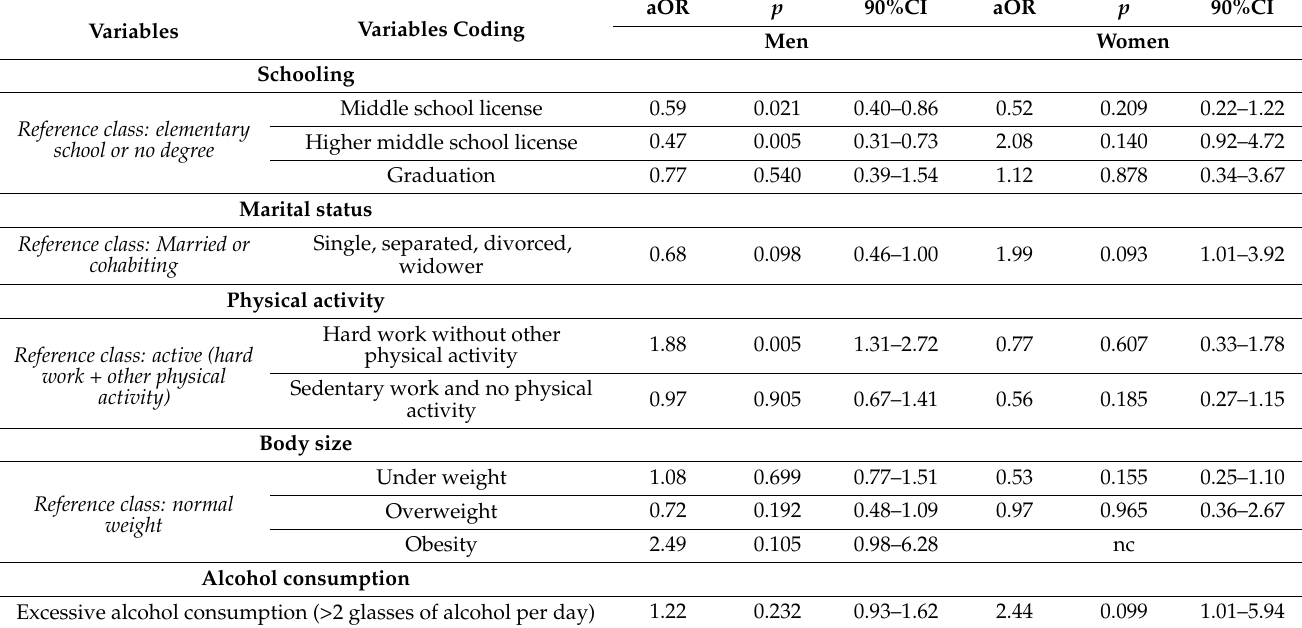
Table 4. Conditional logistic multiple regression analysis of lung cancer risk as a function of socio- demographic factors, lifestyles, disease history, and residential and occupational